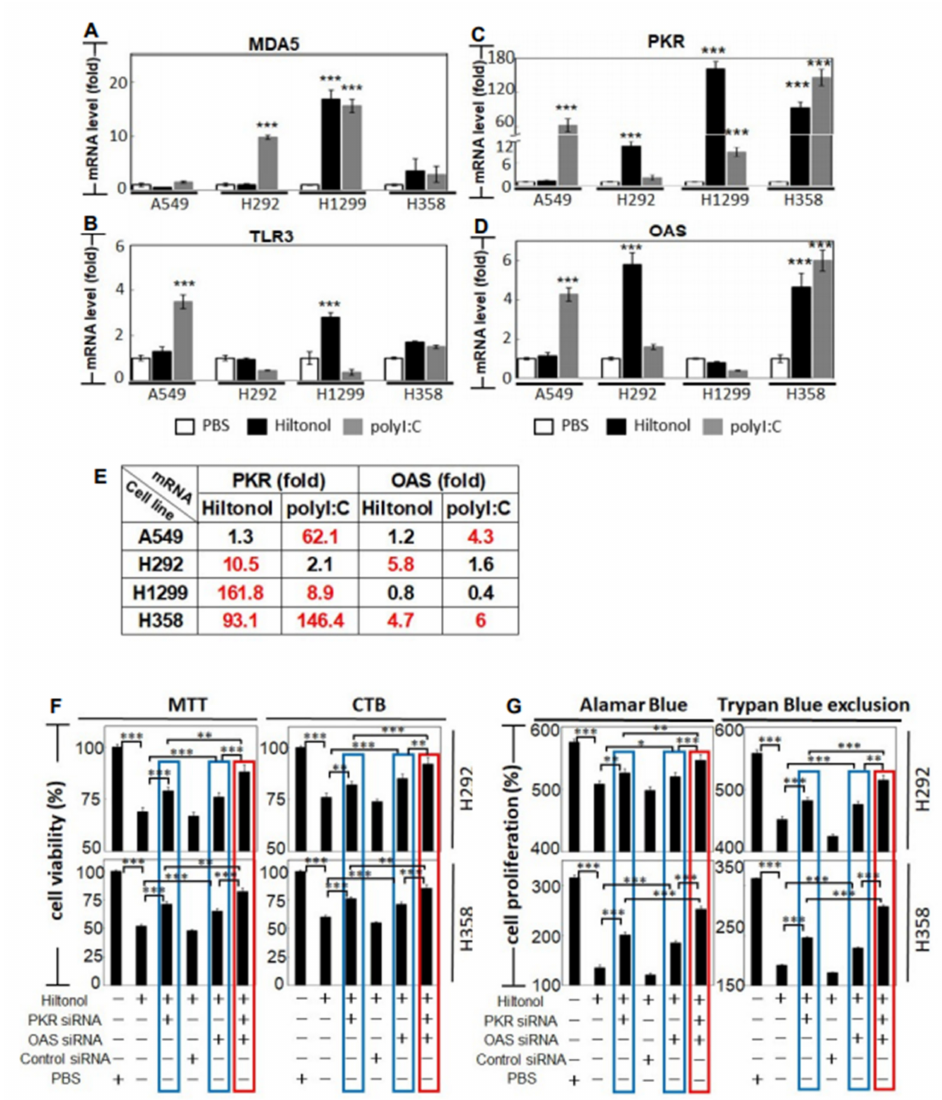
Figure 5. Hiltonol significantly activated tumor suppressors, PKR and/or OAS, in human lung cancer cells. The mRNA expression levels of: ( A ) MDA5 and ( B ) TLR3, ( C ) PKR (p68 protein kinase) and ( D ) OAS (2’5’ oligoadenylate synthetase) were measured. ( A ) LSD value in A549, H292, H1299, and H358 are 0.485, 0.227, 0.862, and 2.028, respectively. ( B ) LSD value in A549, H292, H1299, and H358 are 0.177, 0.319, 0.127, and 0.576, respectively. ( C ) LSD value in A549, H292, H1299, and H358 are 4.991, 0.679, 6.071, and 9.478, respectively. ( D ) LSD value in A549, H292, H1299, and H358 are 0.178, 0.528, 0.371, and 0.327, respectively. ( E ) shows the fold-change in the mRNA levels of PKR and OAS in response to Hiltonol (or polyI:C). The significant changes in the PKR and/or OAS mRNA overexpression in lung cancer cell lines are in red. To measure the effects of PKR and/or OAS in lung cancer upon Hiltonol treatment, 24 h after siRNA-knockdown of PKR or OAS or PKR+OAS double knockdown, NSCLC cells were treated with Hiltonol (or PBS) for 48 h, followed by viability and proliferation studies. ( F ) Cell survival was assayed using MTT and CTB. For each treatment, cell counts were normalized with PBS-treated controls. In MTT assays, LSD value in H292 and H358 are 2.87 and 2.631, respectively. In CTB assays, LSD value in H292 and H358 are 3.102 and 2.801, respectively. ( G ) Cell proliferation was measured using Alamar Blue or Trypan Blue dye exclusion tests. For each treatment, cell counts on 48 h post-treatment of Hiltonol (or PBS) were normalized with the corresponding 0 h treatment controls. PKR (or OAS) -specific siRNA significantly restored Hiltonol-induced cancer cell death and inhibited proliferation in H292 and H358 cells (blue boxes). PKR and OAS double knockdown further improved recovery of cancer cell viability and proliferation during Hiltonol treatment (red boxes). Data are representative of means ± SD ( n = 3). *, p < 0.05; **, p < 0.01; ***, p < 0.001. In Alamar Blue assays, LSD value in H292 and H358 are 5.934 and 4.628, respectively. In Trypan Blue exclusion studies, LSD value in H292 and H358 are 4.978 and 1.743,